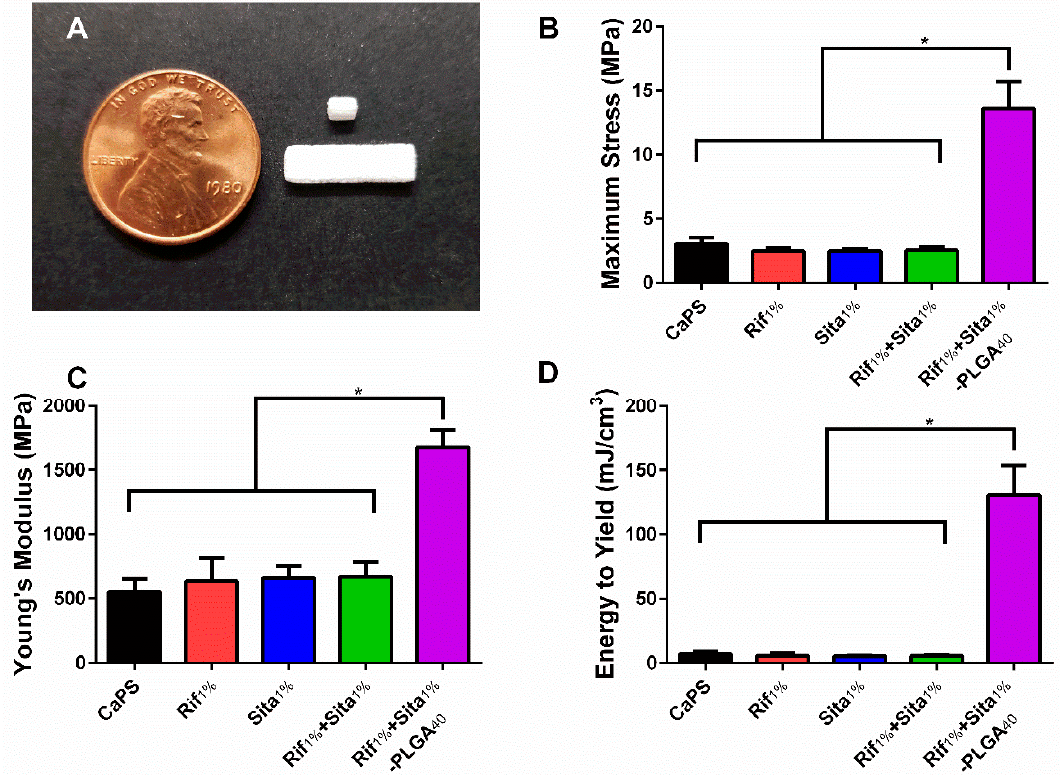
Figure 2. Incorporation of rifampin and sitafloxacin does not affect the material properties of 3D printed calcium phosphate scaffolds (CaPS). ( a ) Ellipsoidal cylinders (1.2 × 2 × 3 mm) were 3D printed